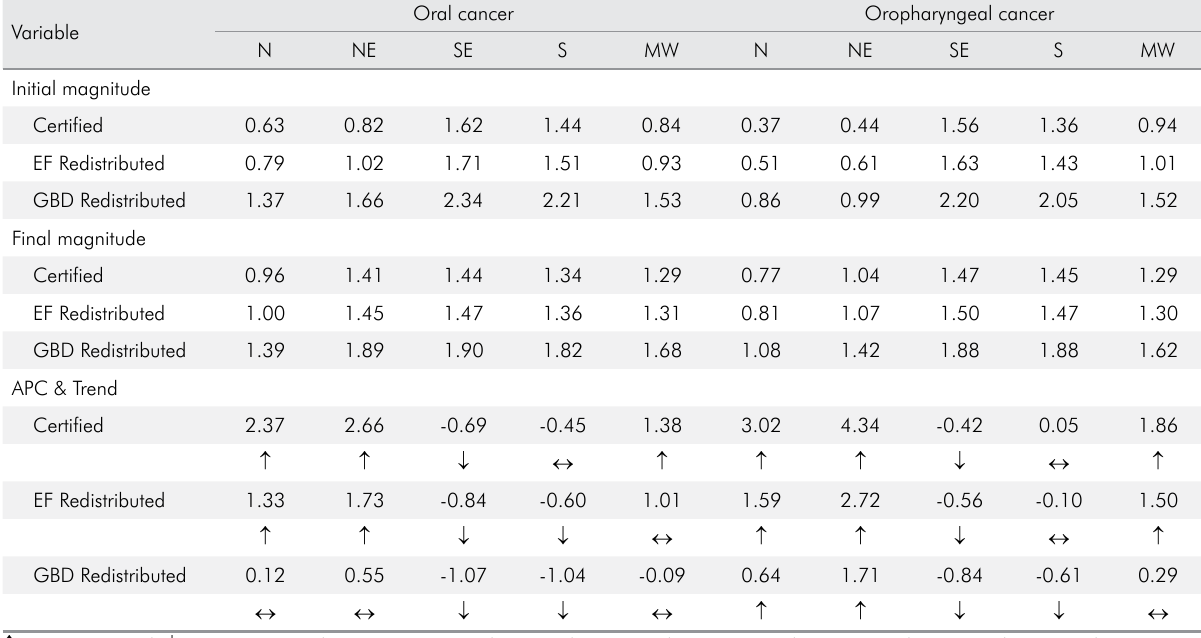
Table 2. Certified versus redistributed mortality of oral and oropharyngeal cancer by the EF and GBD methods by macroregion, for 100,000 inhabitants: initial and final magnitude, annual percent change (APC), and trends. Brazil, 1996-2018.